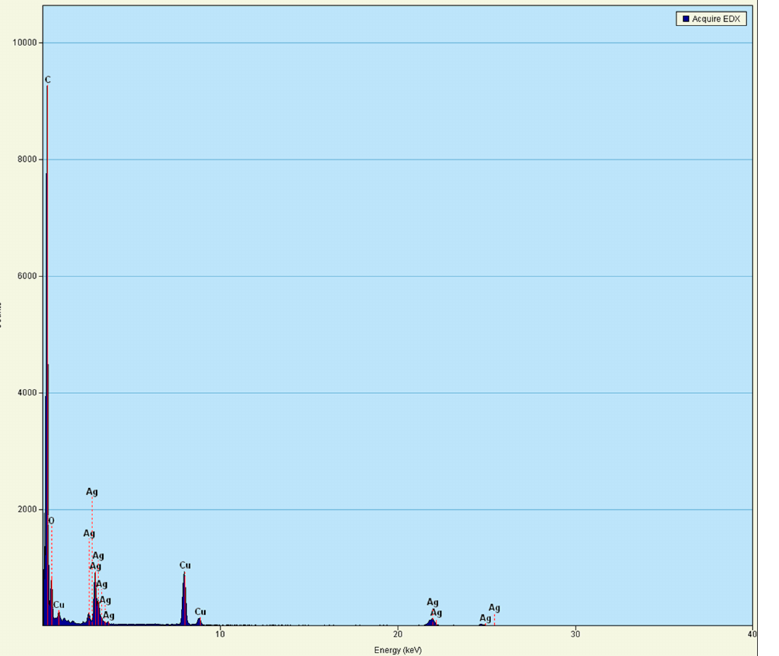
Figure 4. Transmission electron microscopy (TEM) micrograph of AgNPs produced by Streptomy- ces aizuneusis ( A ) and particle size distribution curve ( B ) . A